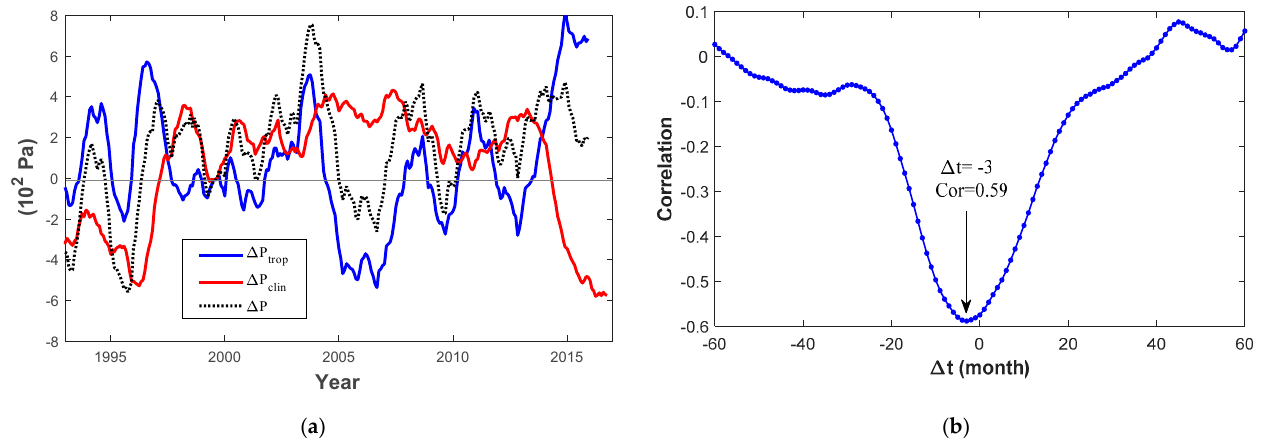
Figure 7. The variation ( a ) and the correlation for different lag time lengths ( b ) of ∆ P trop and ∆ P clin . The high P clin correlation with the station in the southern part of the Norwegian Sea (64 N, 2 W) is limited to a small area in the southern part of the Norwegian Sea (the